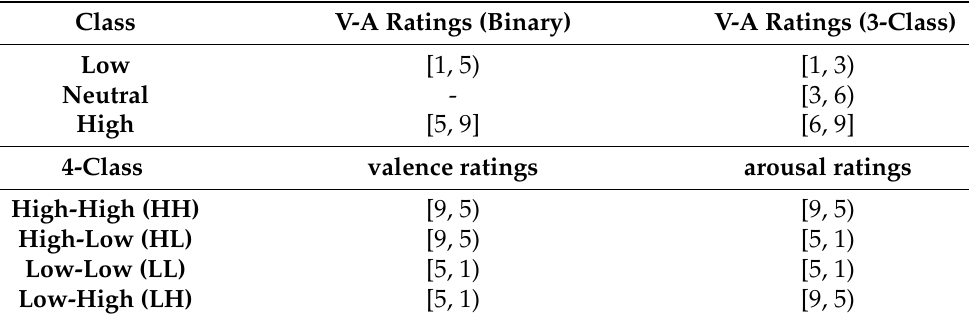
Table 3. The mapping of V-A values and discretized